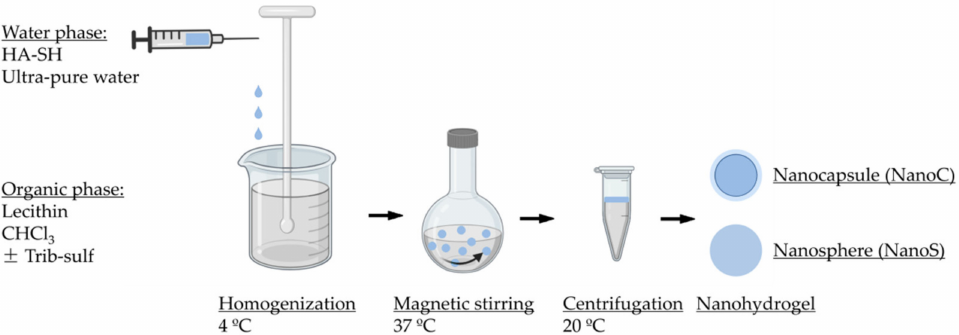
Figure 1. Schematic of nanocapsule (NanoC) and nanosphere (NanoS) formulation